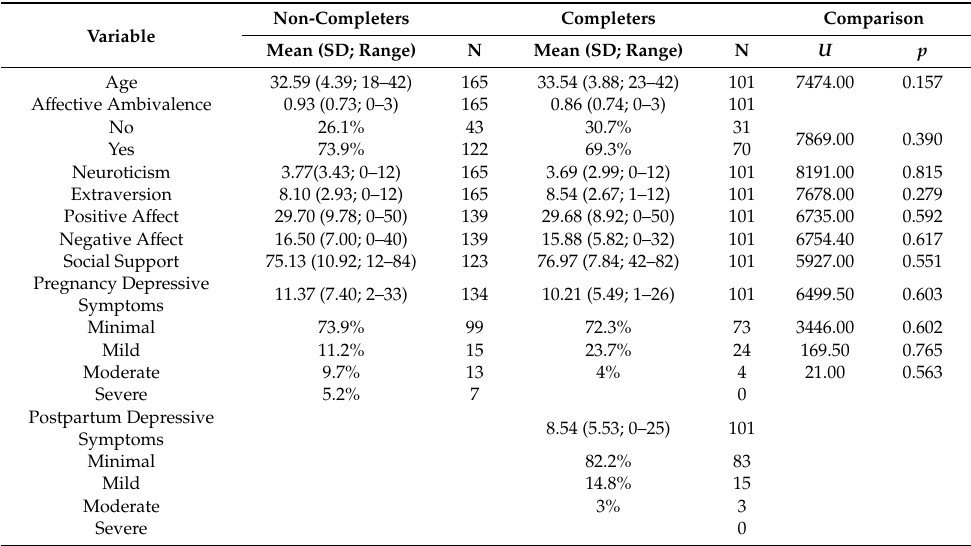
Table 2. Biopsychosocial variables during pregnancy and